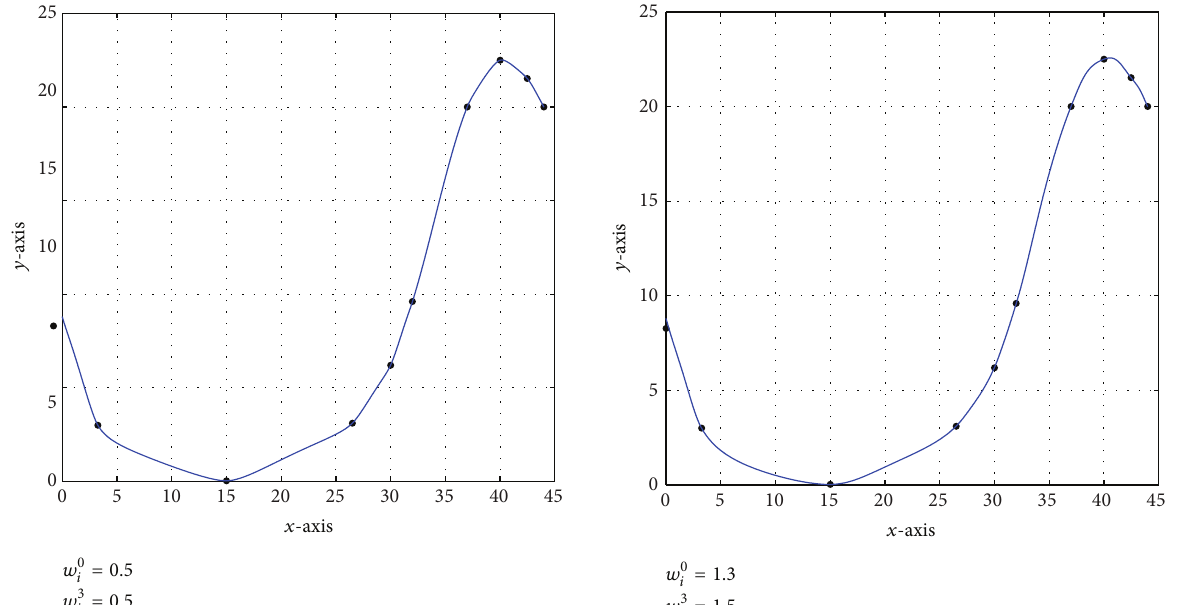
Figure 4: Positive curve by rational cubic trigonometric spline with different values of free parameters.